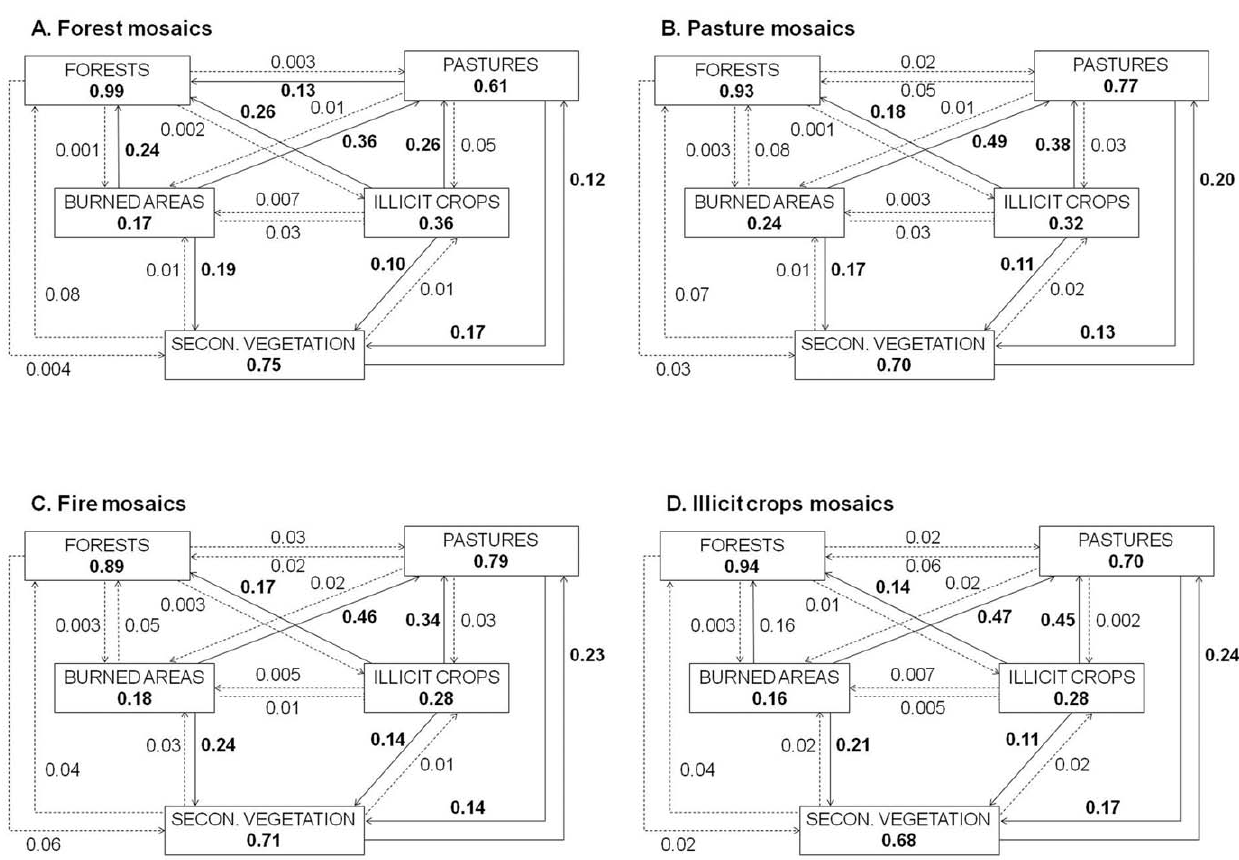
Figure 5. Average land use changes of the yearly values in Forest mosaics. (A); Pasture mosaics (B); Fire mosaics (C); and Illicit crop mosaics (D). Numbers in bold indicate transitions .